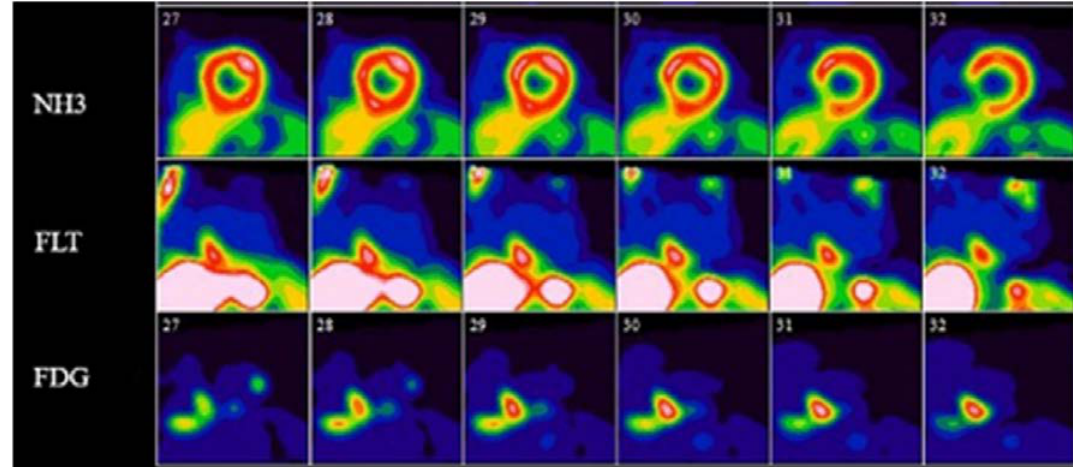
Figure 5. Short axis 13 N-ammonia perfusion, 18 F-FDG-, and 18 F-FLT-PET images in a patient with active cardiac sarcoidosis. 13 N-ammonia perfusion images (top row) show scarring of the inferior ventricular septum, with both FDG- and FLT-PET images showing evidence of active cardiac sarcoidosis in this area. Reprinted from ref. [75].